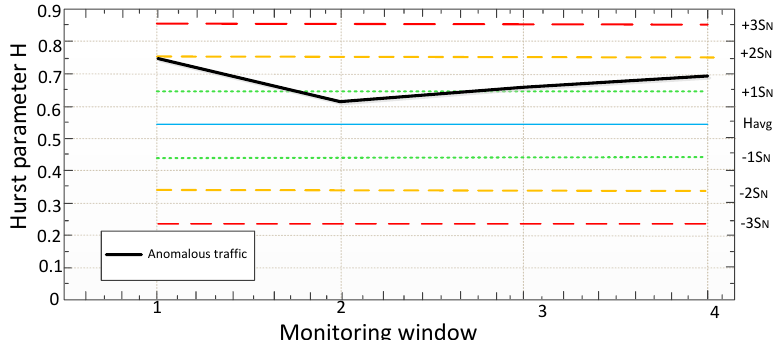
Figure 28. Values in 60 seconds with a 15-second monitoring window for the "anomaly" class (Non-Spoofed UDP Floods attack).